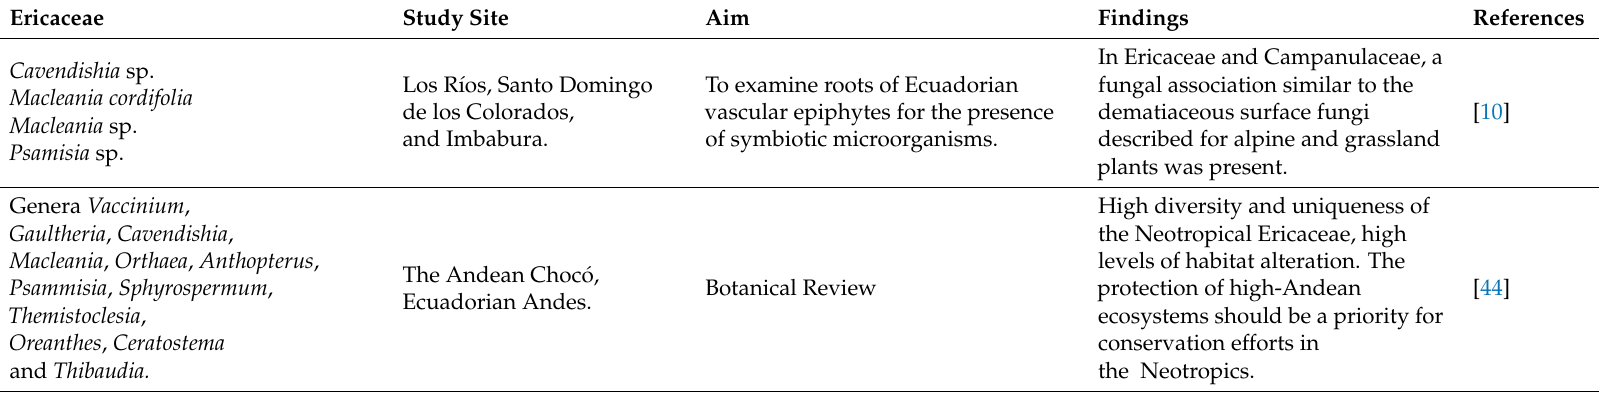
Table 1. Research associated with Ericaceae from Ecuador and their mycorrhizal